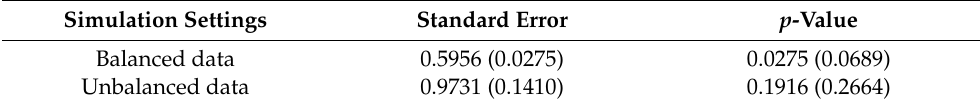
Table 1. The mean (standard error) of the simulation example across 100 replications. Simulation